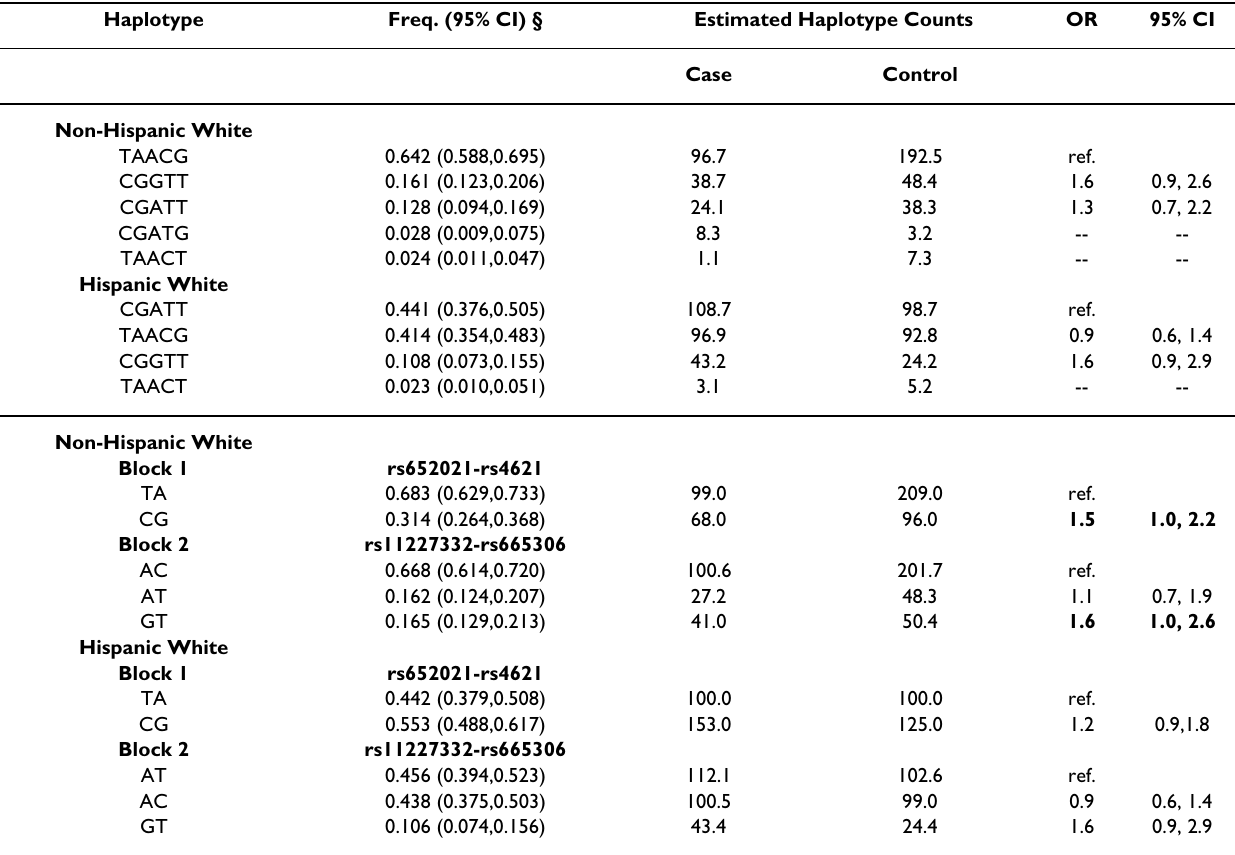
Table 4: Associations between haplotypes and spina bifida risk, non-Hispanic White vs . Hispanic White